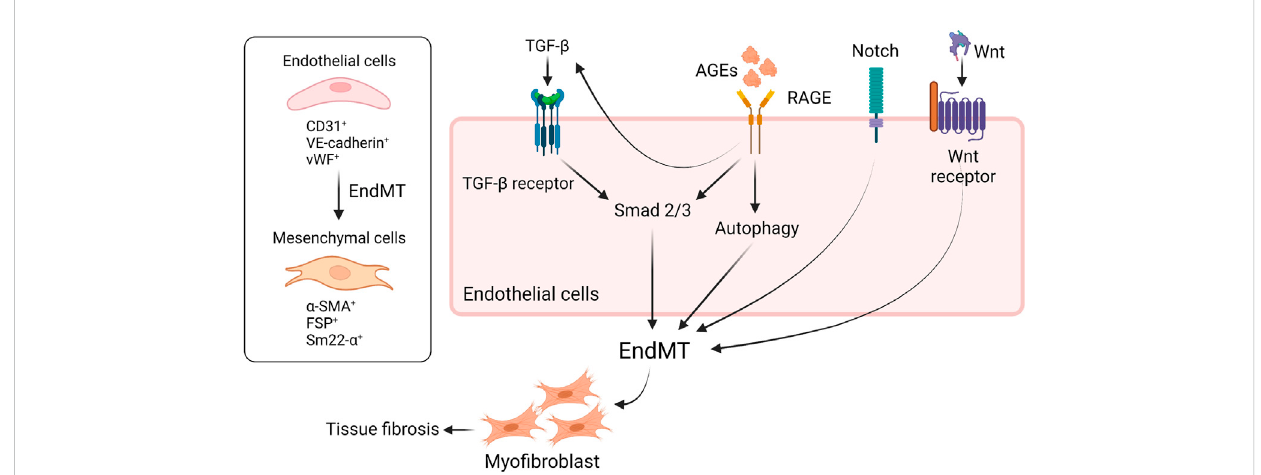
FIGURE 2 RAGE and other signaling are implicated in EndMT in diabetes. EndMT contributes to tissue fi brosis in diabetic condition. The engagement of RAGE with AGEs induces EndMT through the activation of Smad2/3 or aberrant upregulation of autophagy. TGF- β also activates Smad2/3, leading to EndMT. RAGE-induced increase in TGF- β ampli fi es EndMT, resulting intissue fi brosis. Besides, Notch signaling or Wnt/ β -catenin pathway is involved in EndMT as well. EndMT, endothelial-to-mesenchymal transition; TGF- β , tissue growth factor-b; RAGE, receptor for advanced glycation endproducts; VE- cadherin, vascular endothelial-cadherin; vWF, von Willebrand factor; α -SMA, a-smooth muscle actin; FSP, fi broblast-speci fi c protein; sm22- α , smooth muscle protein